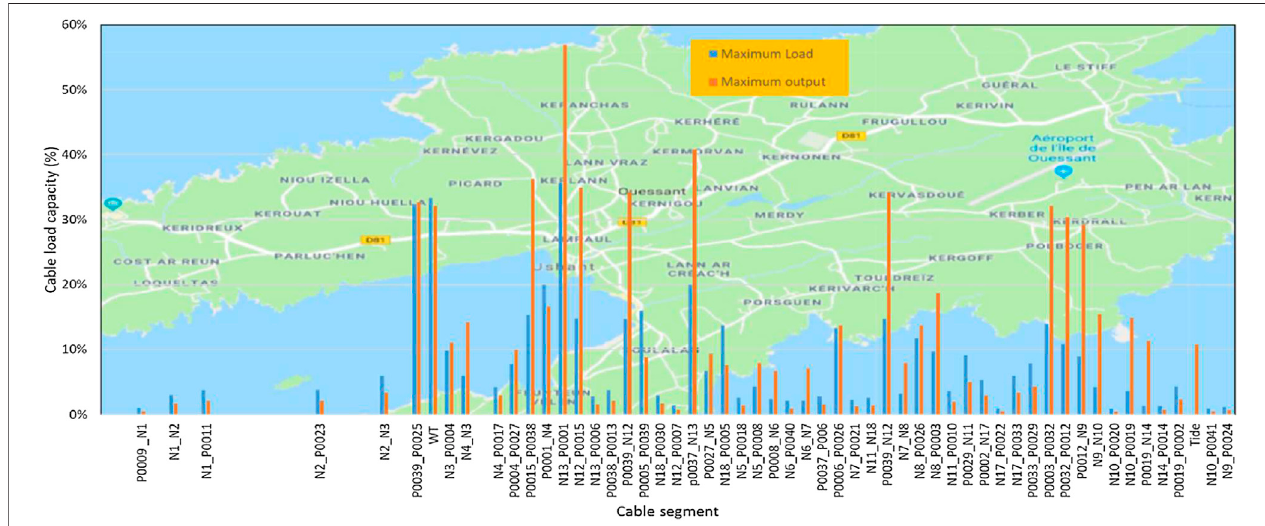
FIGURE 13 | Cable used capacity under maximum load demand and maximum renewable energy generation power output (case 1).